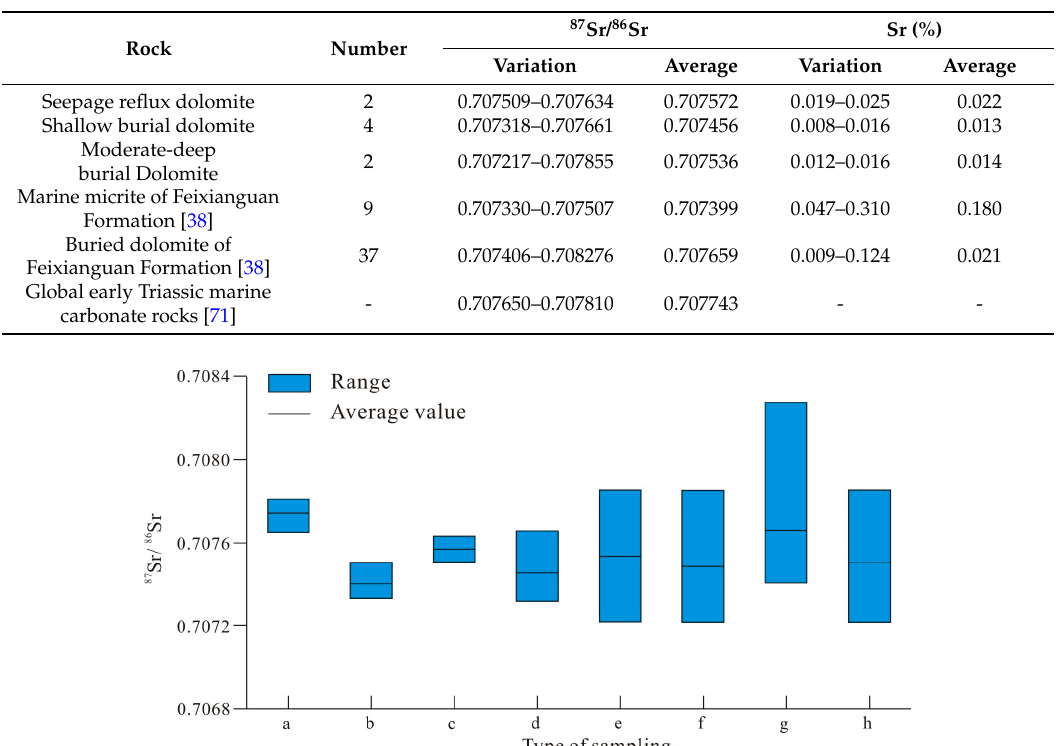
Table 4. Sr contents and isotopic data for dolomites from the Yudongzi outcrop.